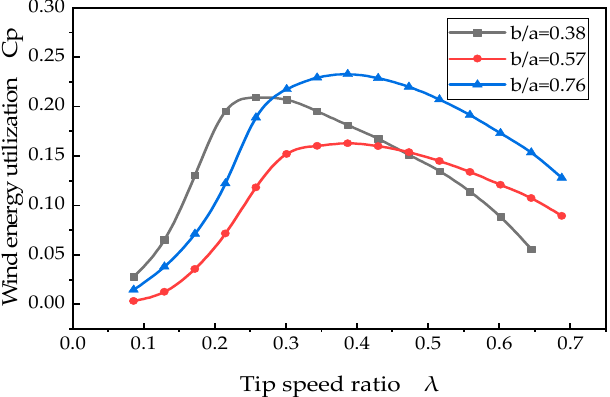
Figure 15. Comparison curve of wind energy utilization with different ratios of the major axis to the minor axis.